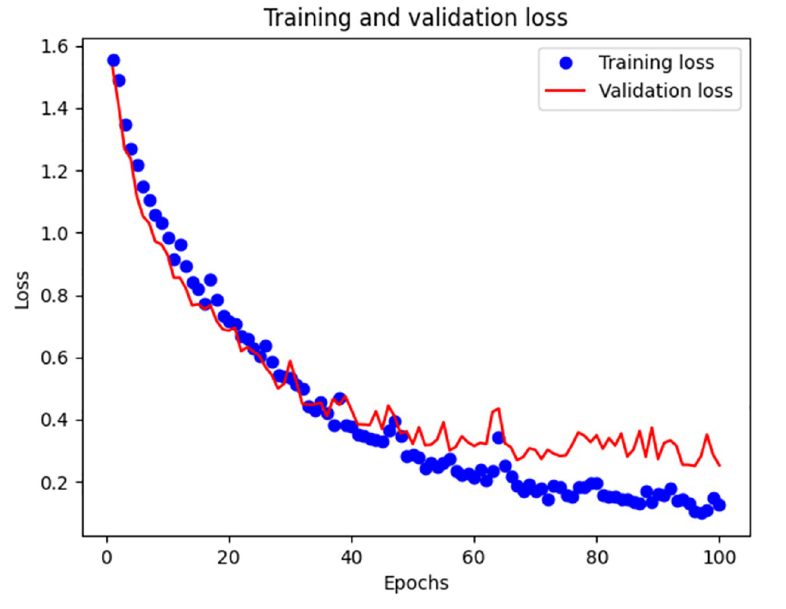
Fig 7. Variation of loss.